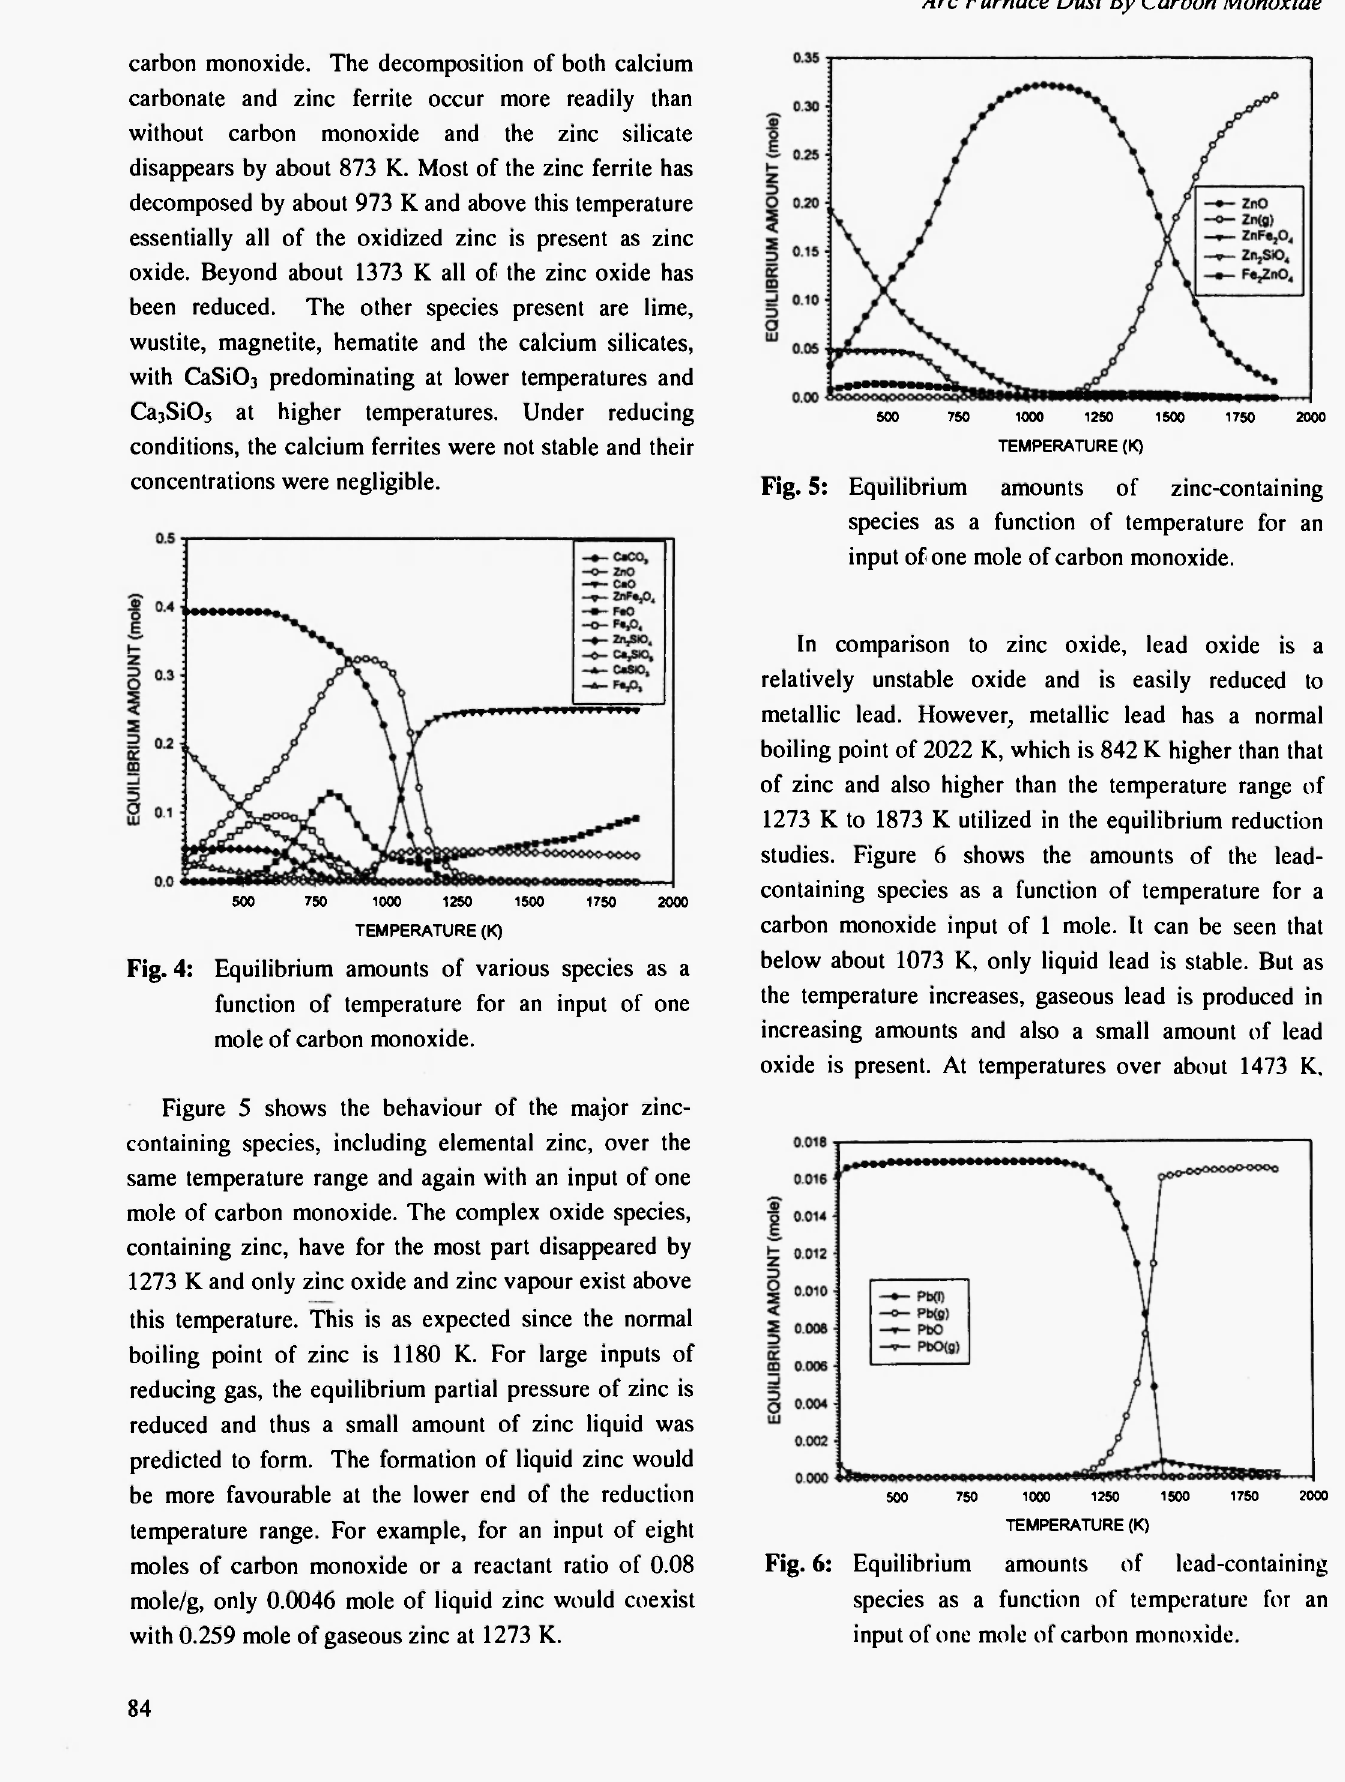
Fig. 5: Equilibrium amounts of zinc-containing species as a function of temperature for an input of one mole of carbon monoxide.